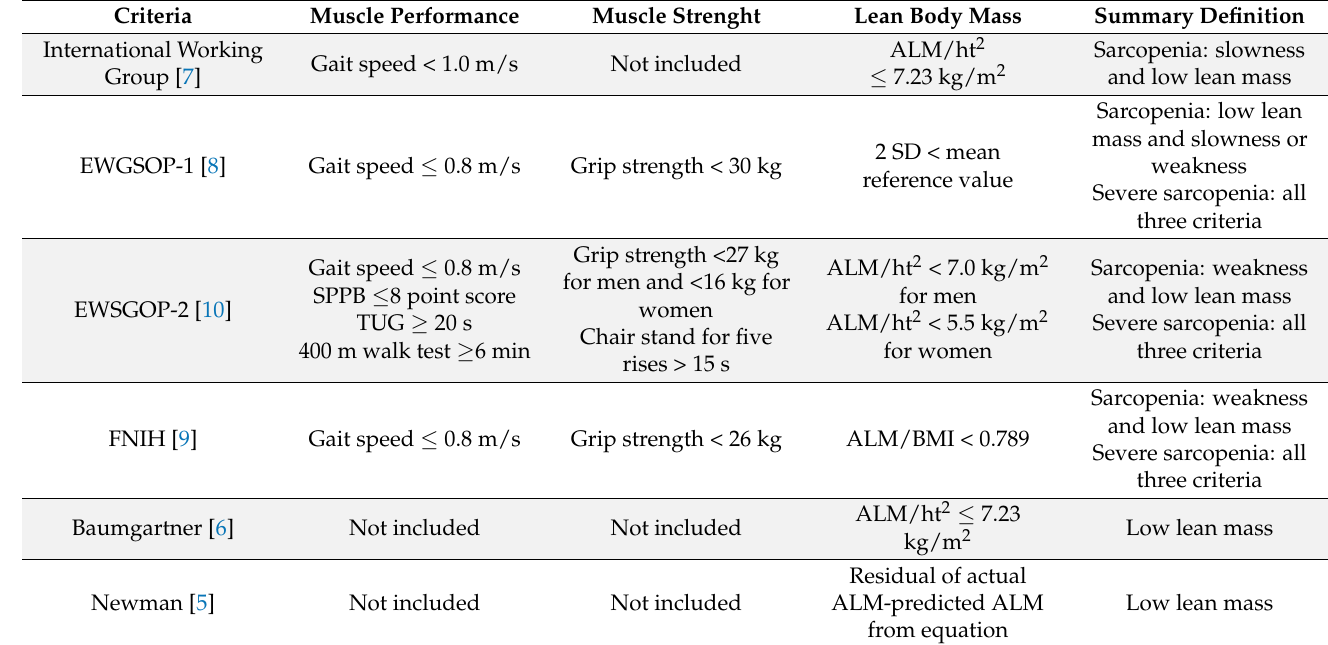
Table 1. Different criteria for the diagnosis of